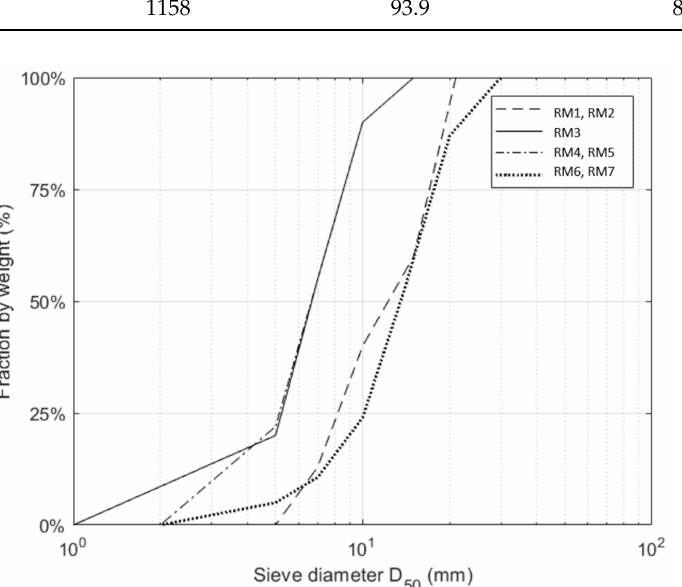
Figure 6. Grading curves of the model rock